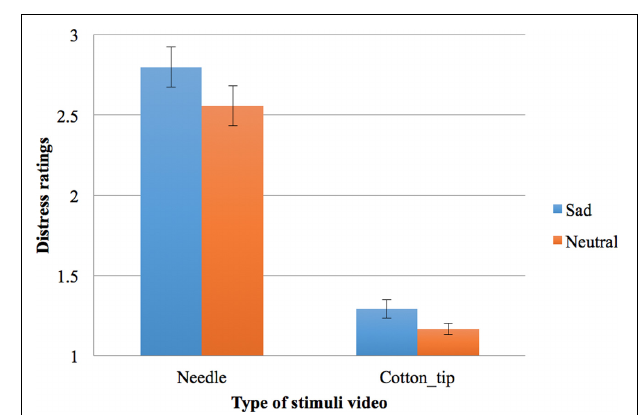
FIGURE 2 | Participant sample one’s distress ratings on a scale from 1 to 5 (1 = not distressing at all, 5 = very distressing) for two types of stimuli (painful needles or non-painful cotton-tips) in the two mood conditions (bars shown are standard errors).